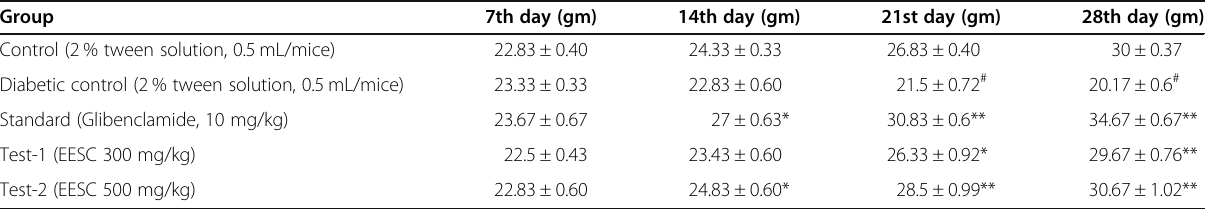
Values are expressed as mean±standard error of mean ( n =6) EESC Ethanolic extract of S. caseolaris ( L.) Engl # Indicates p <0.0001 compare with control *Indicates p ˂ 0.05 compare with STZ control ** Indicates p ˂ 0.0001 compare with STZ control